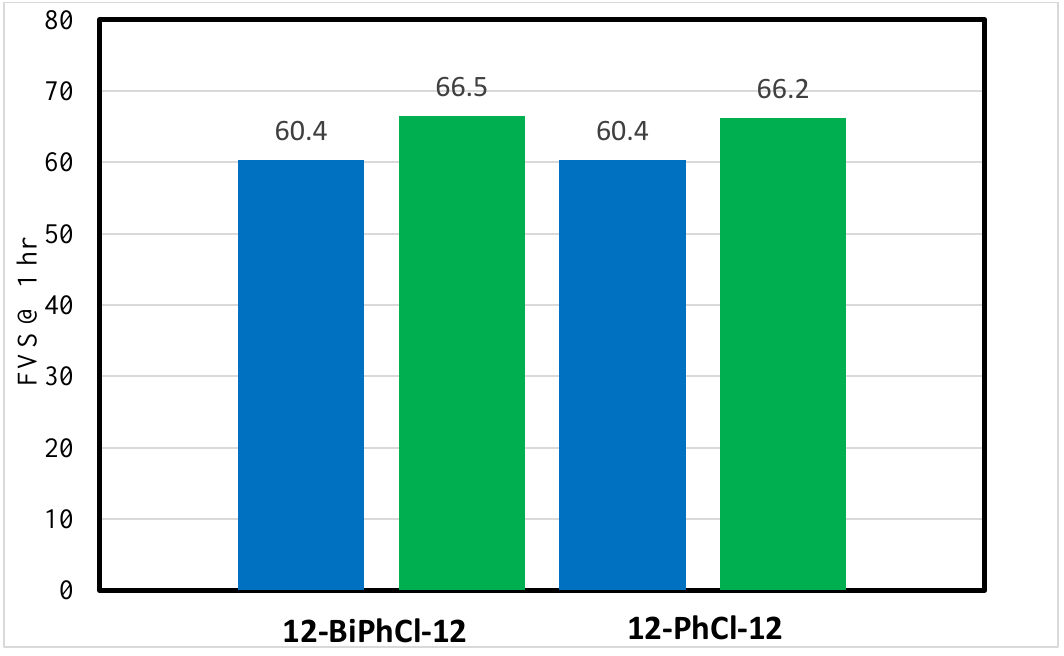
Figure 7. Foam volume stability of surfactants 12-PhCl-12 and 12-BiPhCl-12 in deionized water and SW.